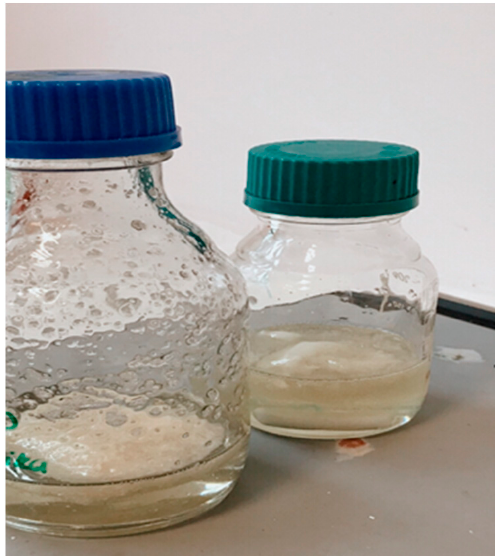
Figure 1. PES and PVDF membrane solutions.